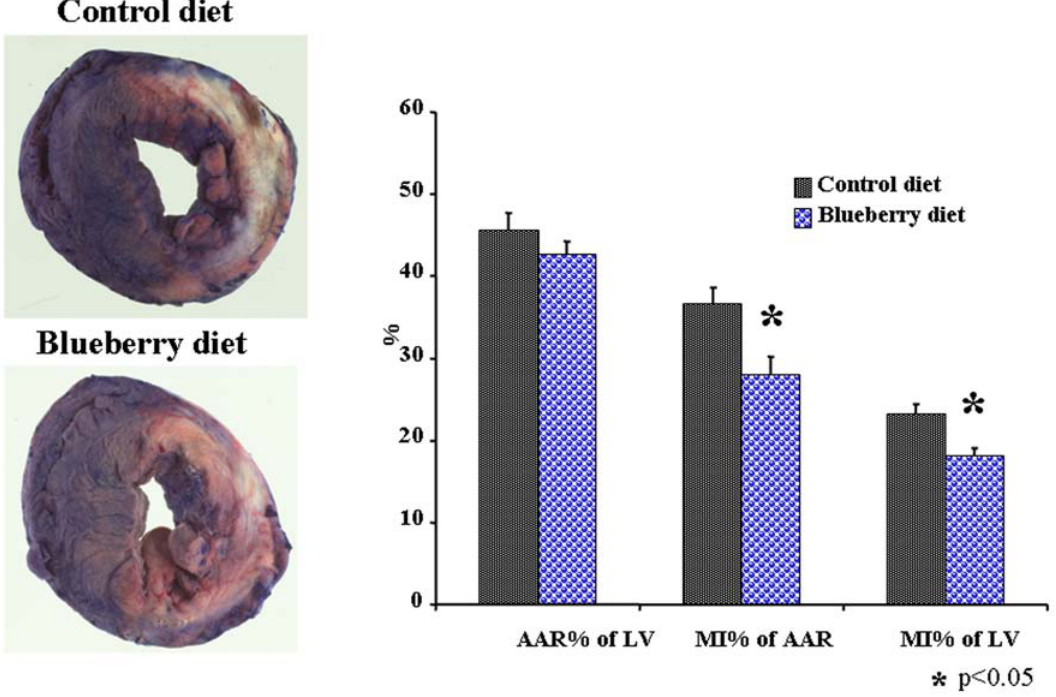
Figure 2. MI 24 hrs following permanent coronary ligation. On the left are samples of the hearts of BD and CD rats subjected to TTC staining: white - necrotic area; red - area at risk (AAR); blue - viable, well-perfused myocardium. On the right is the graph comparing the AAR expressed as a percent of LV and MI size expressed as a percent of LV or AAR in BD and CD rats. *- p , 0.01 vs. CD.